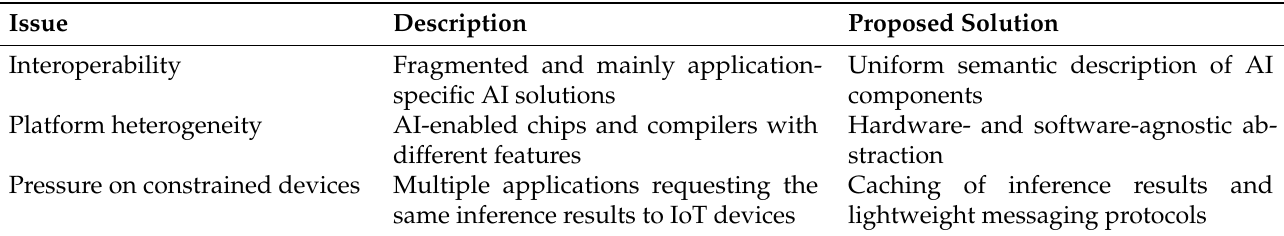
Table 1. AI at the deepest edge: main issues and our